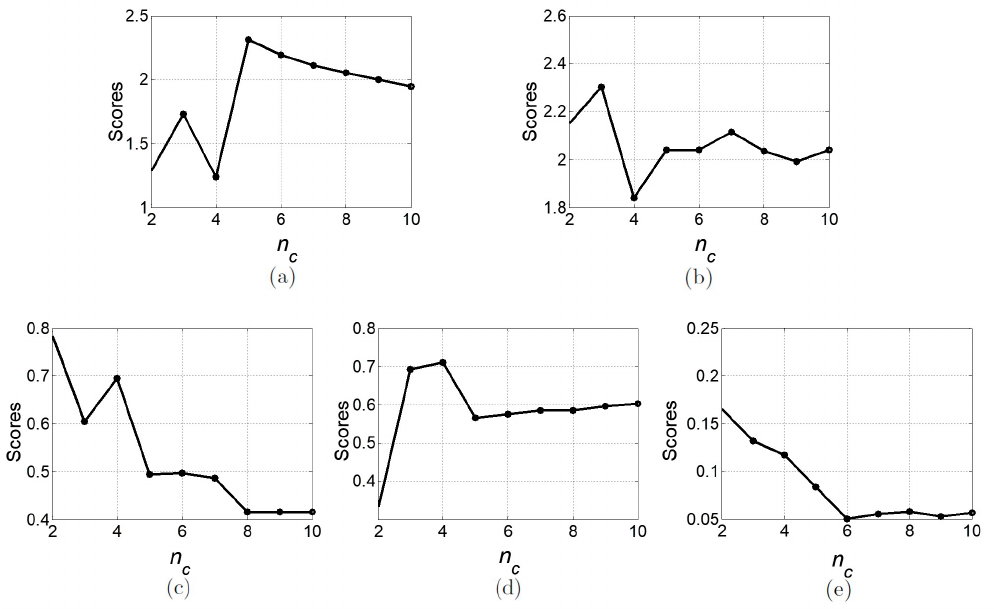
Figure 12. Evolution of CVIs for autumn using HC for n c clusters indicated by: ( a ) XB ( ↓ ); ( b ) DB ( ↓ ); ( c ) DI ( ↑ ); ( d ) WI ( ↑ ); ( e ) Sil ( ↑